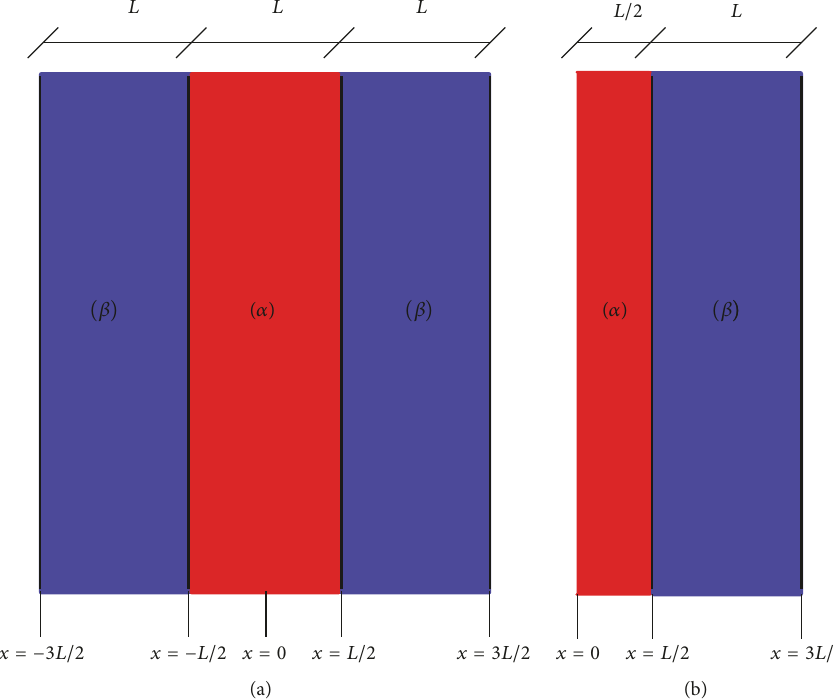
Figure 1: Schematic of (a) the entire system and (b) the half-symmetric part modelled. Layer 𝛼 represents copper while 𝛽 indicates niobium, nickel, or